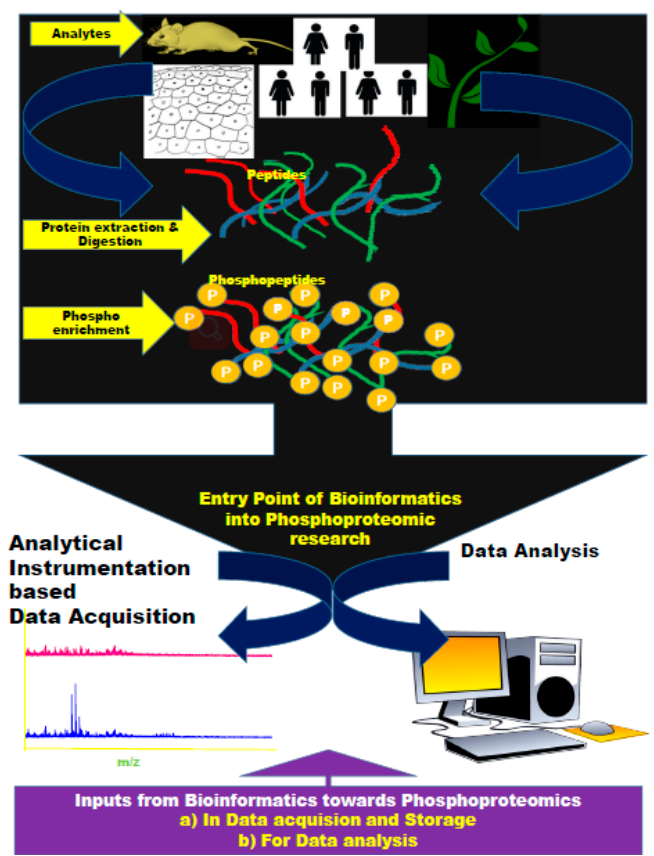
Figure 1. Work flow of phosphoproteomics indicating entry points where bioinformatics tools come handy.